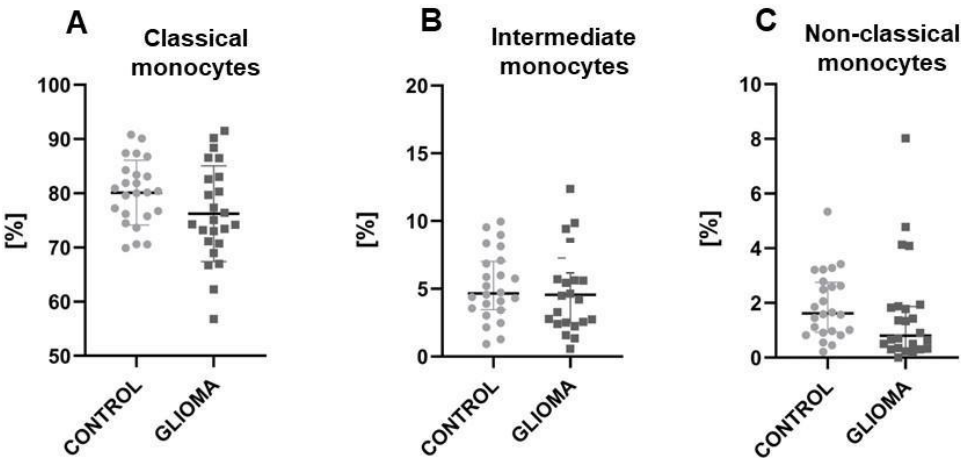
Figure 1. The results for the three monocyte subpopulations’ frequency based on the CD14, CD16 and SLAN expression. The comparison between glioma patients and the control group showed less numerous representations of classical and non-classical glioma patients’ monocytes. Unpaired t -student was used for graph A. In other cases U Mann-Whitney was used.